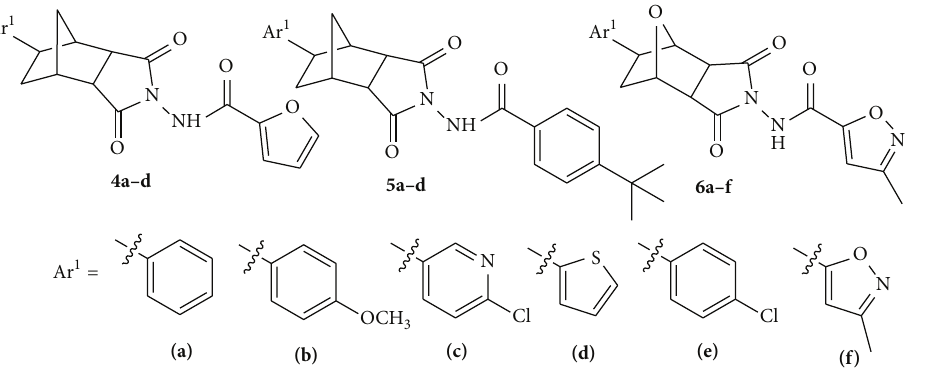
Figure 3: Synthesis of N -acylamino-substituted tricylic imides.